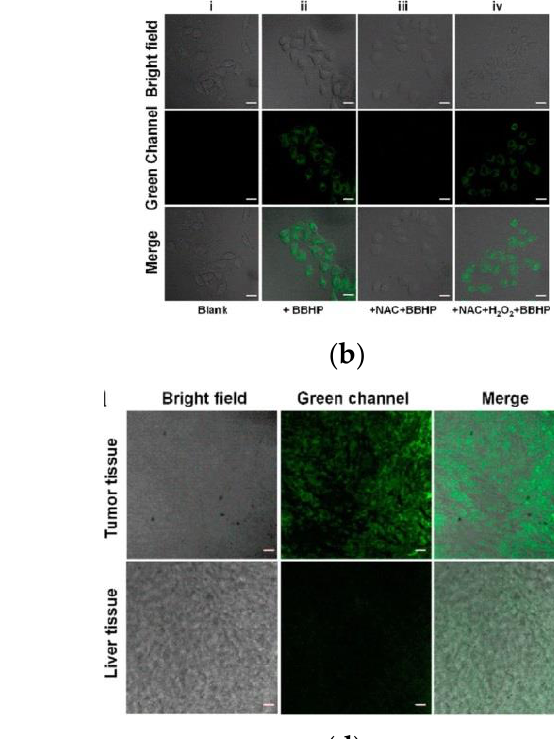
Figure 32. ( a ) Mechanism of the probe activation by H 2 O 2 ; ( b ) Fluorescence responses of probe NH-MT toward different concentrations of H 2 O 2 ; ( c ) Fluorescence imaging in HepG2 cell. Repro- duced with permission from [138]. Copyright 2021 Elsevier B.V.